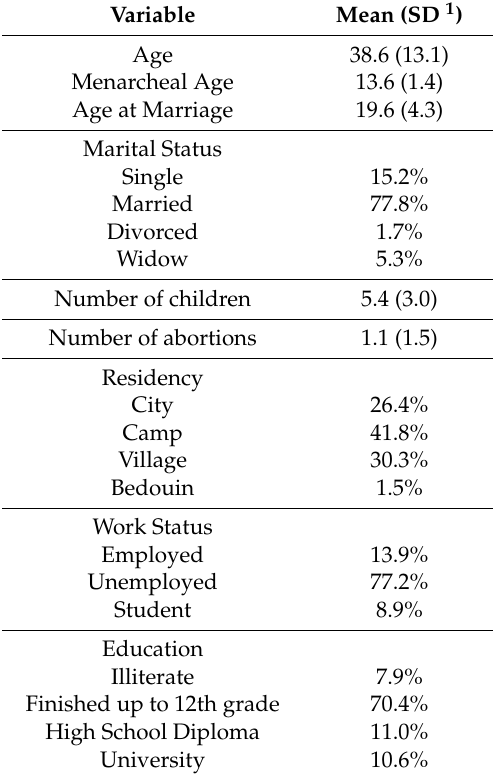
Study sample characteristics ( n = 1694) for refugee women (15–84 years), West Bank/Palestine